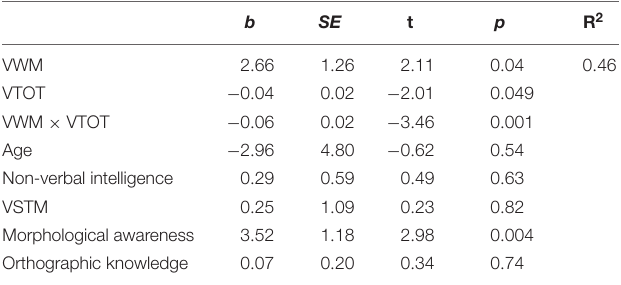
TABLE 2 | The results of moderation effect analysis.